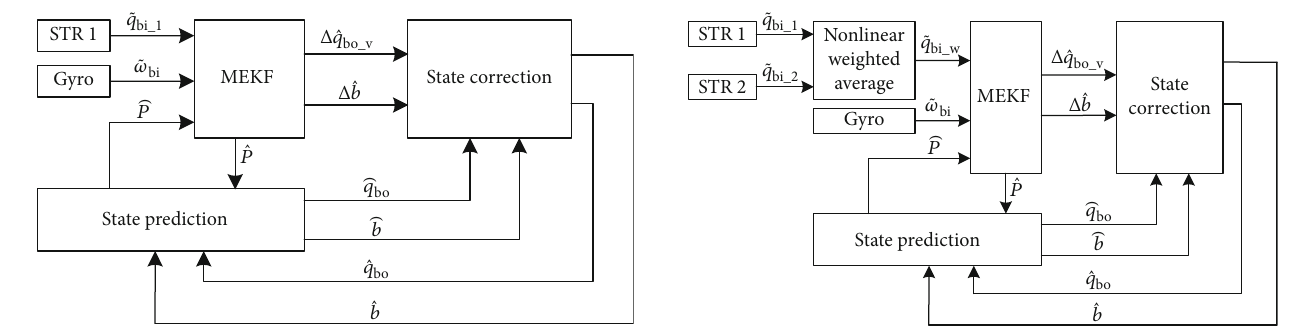
Figure 5: The centralized layout I. Figure 6: The centralized layout II.